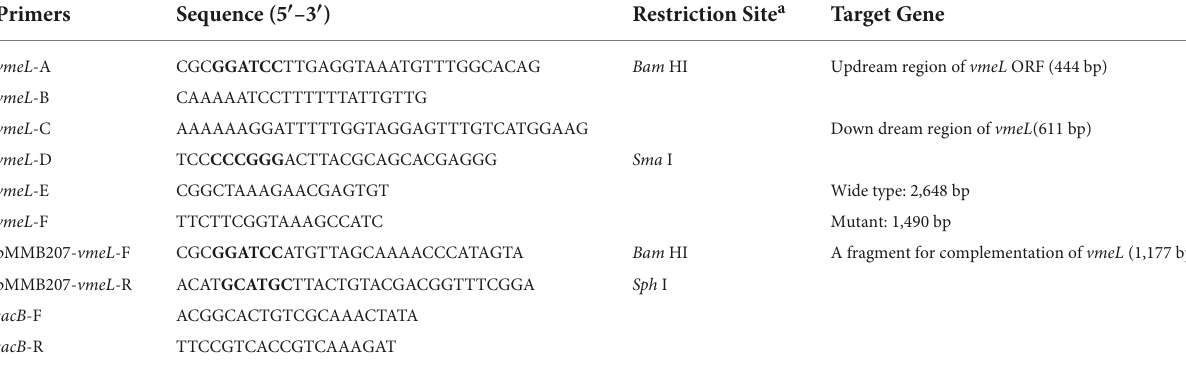
TABLE 2 Primers were used to construct (cid:49) vmeL and C (cid:49)